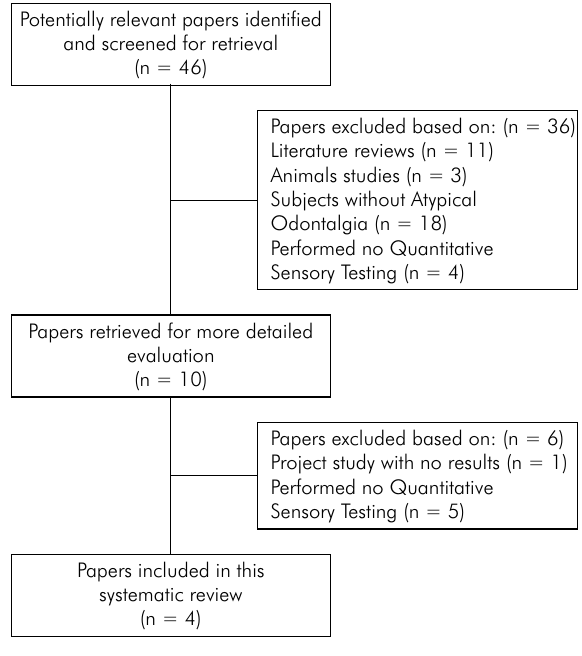
Figure 1. Flow diagram of the selection process for this systematic review.